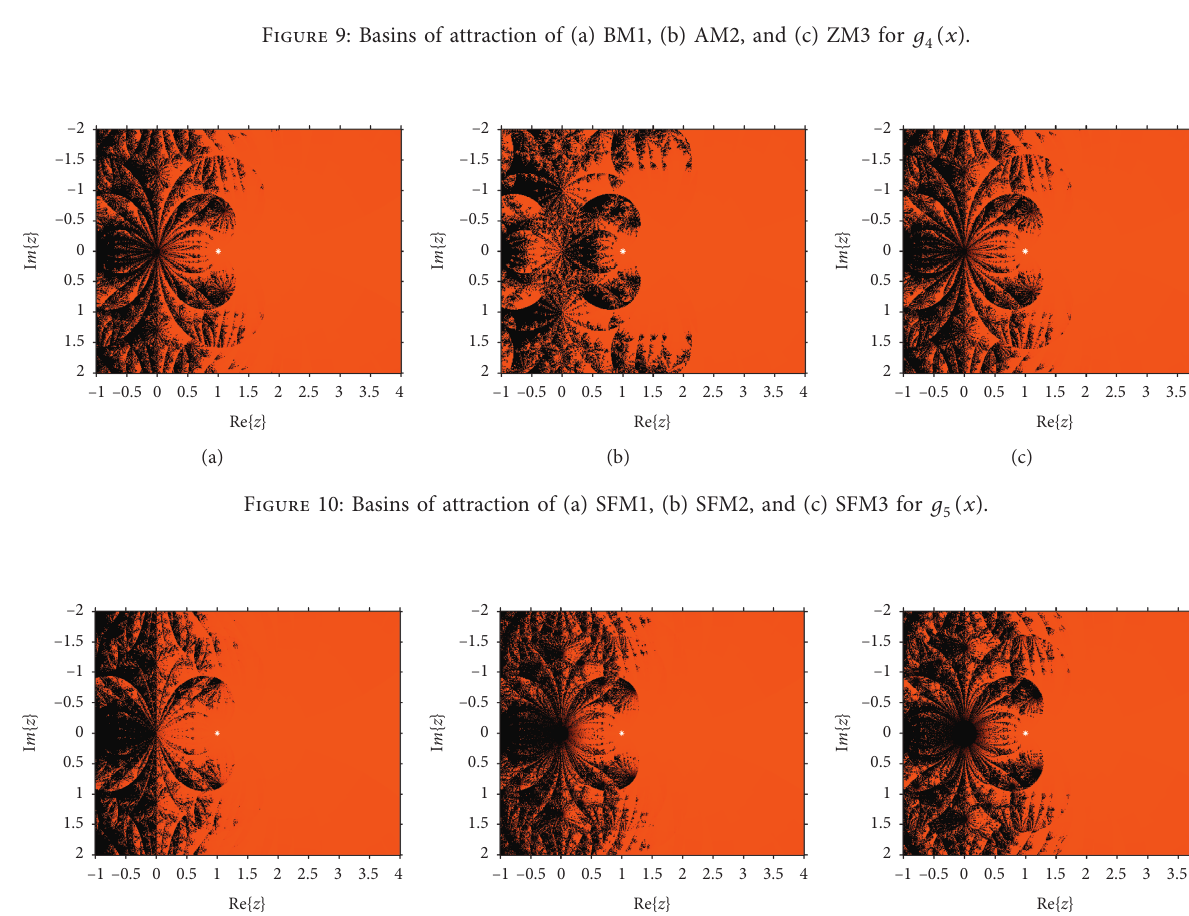
( x ) 5 ( x ) and these numerical results 7